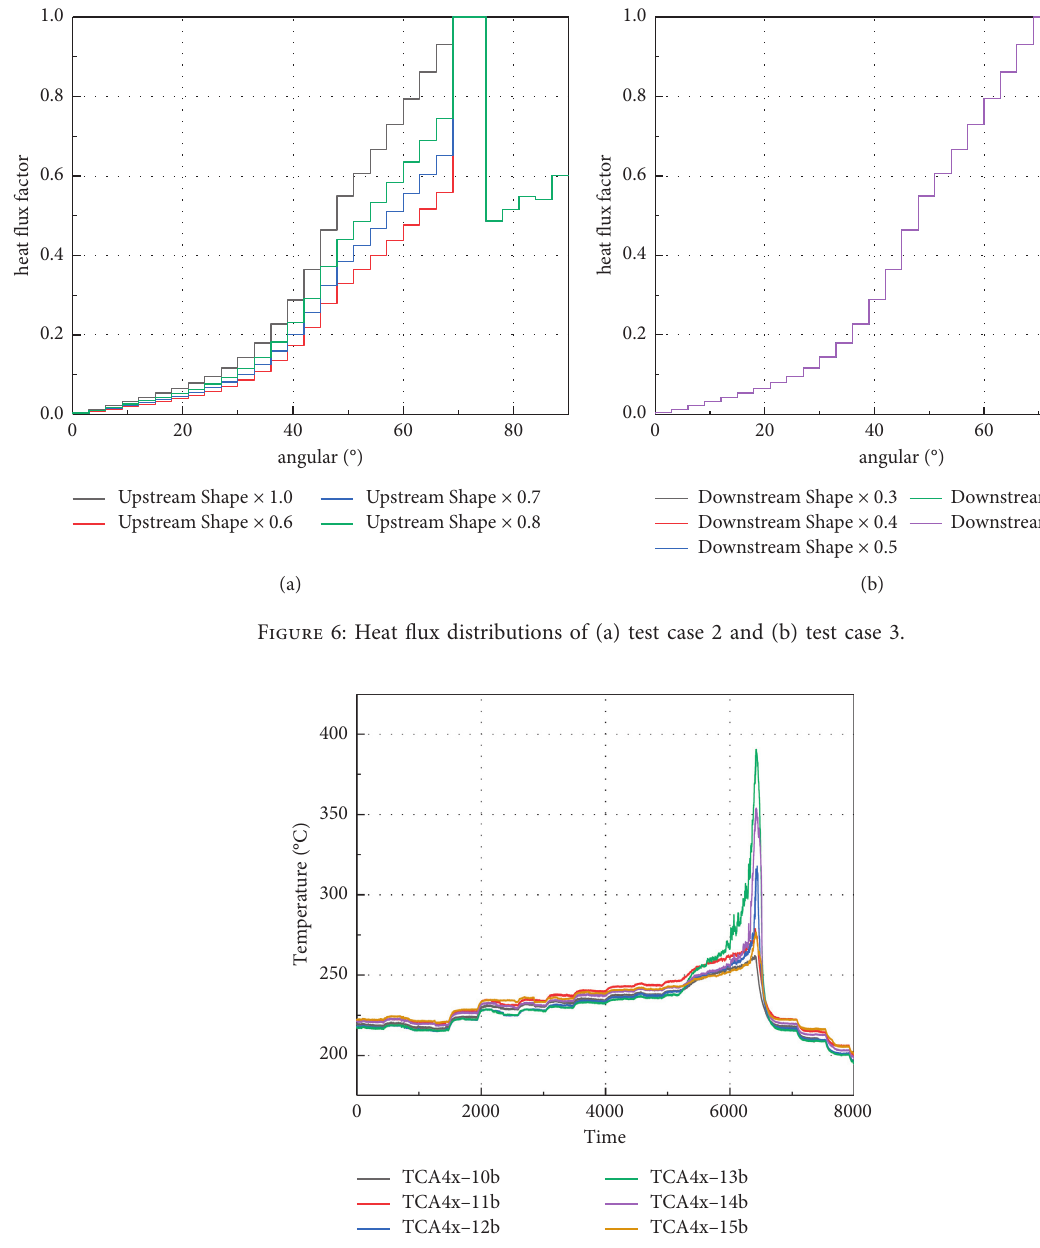
Figure 7: Example of temperature jump when CHF is